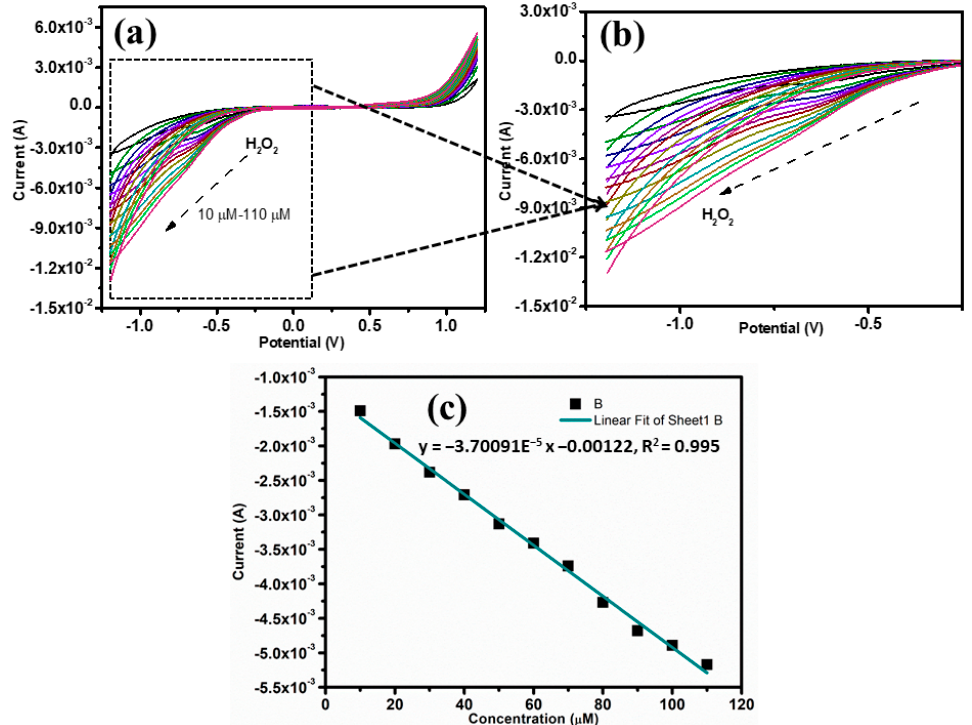
Figure 6. ( a ) CVs shows electrochemical performance with di ff erent H 2 O 2 concentrations in 0.1 M PBS (pH = 7.0) at a scan rate of 0.08 Vs − 1 ; ( b ) enlargement of 5a which show the linearity of the sensing performance of Fe 3 O 4 /Gr/CC; and ( c ) a calibration plot for varying concentrations versus peak